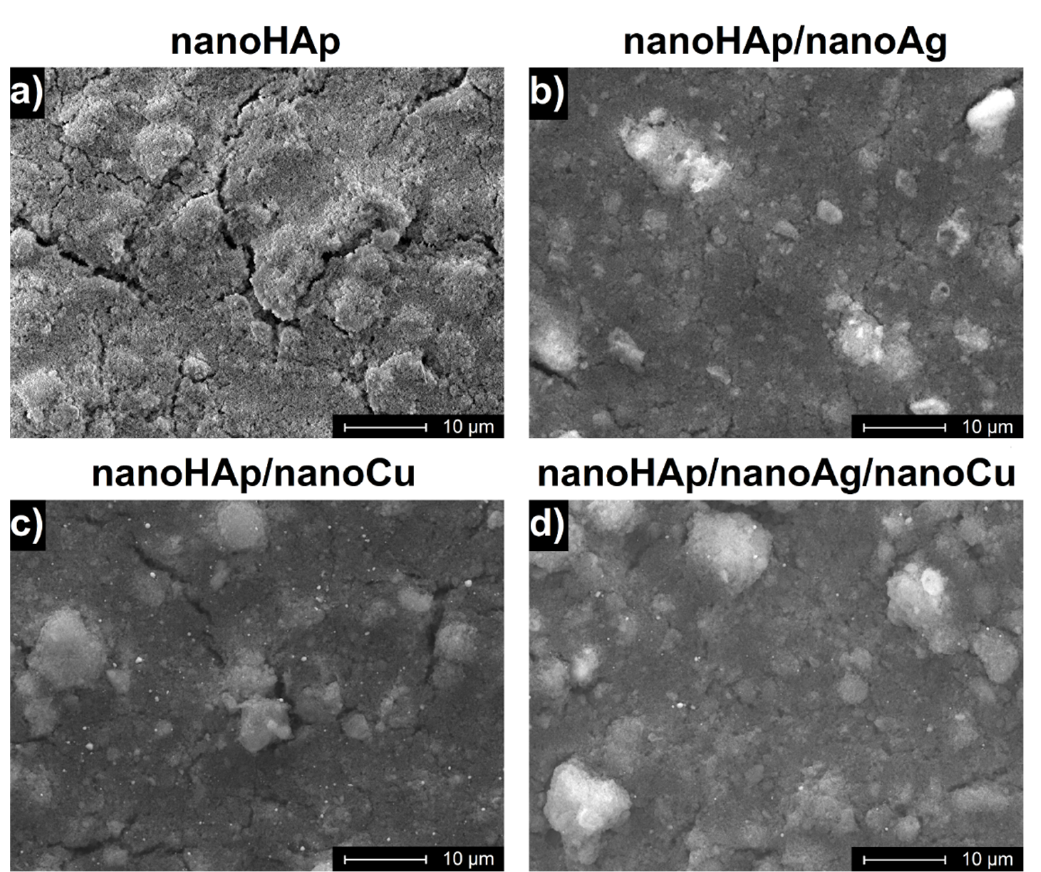
Figure 1. SEM images of the: ( a ) nanoHAp, ( b ) nanoHAp/nanoAg, ( c ) nanoHAp/nanoCu, and ( d ) nanoHAp/nanoAg/ nanoCu